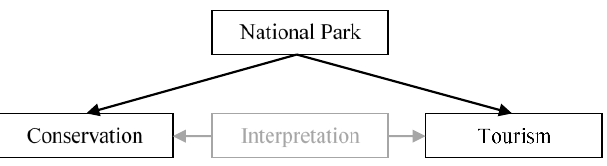
Figure 1: Interpretation’s link between the tourism and conservation functions of a national